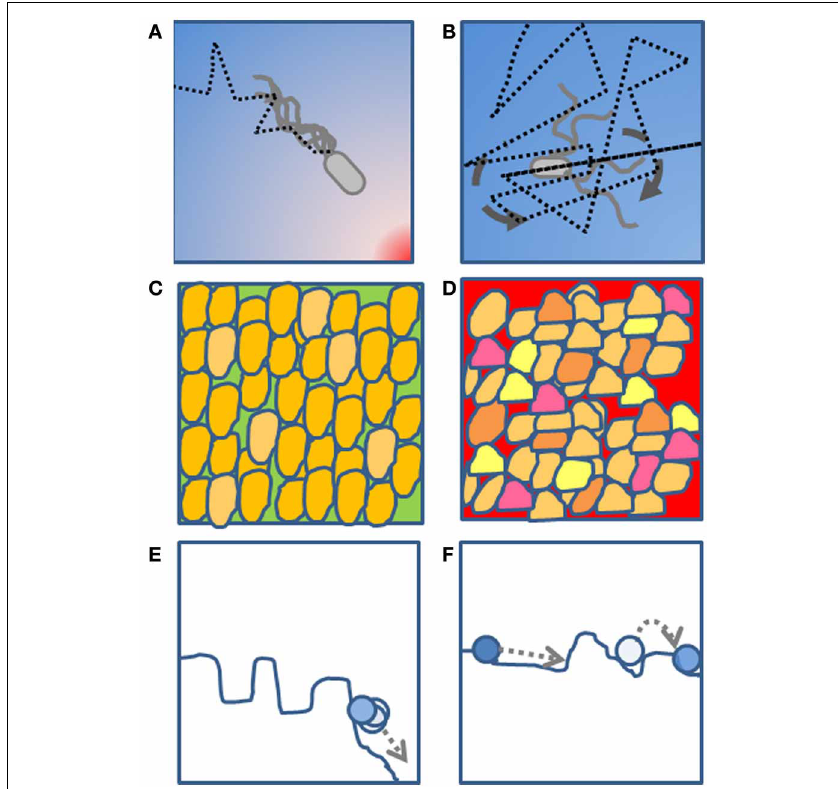
FIGURE 1 | A schematic diagram of the proposed analogy. (A) A bacterium moving toward a source of food through a random walk biased by the chemical concentration gradient. (B) A bacterium tumbling most of the time and performing a non-biased random walk in the absence of a chemical gradient. (C) A phenotypically homogeneous yeast population growing in a rich medium in the absence of a perturbation. (D) A phenotypically heterogeneous yeast population growing under a chemical perturbation, where presumably the heterogeneity is a strategy to ensure survival of at least a few cells during the perturbation. (E) A fitness landscape with clear minima (valleys) and where the homogeneous population is coordinately descending toward the global minimum. (F) A flatter fitness landscape where, in absence of a clear gradient, the population explores various regions through heterogeneity in the single-cell